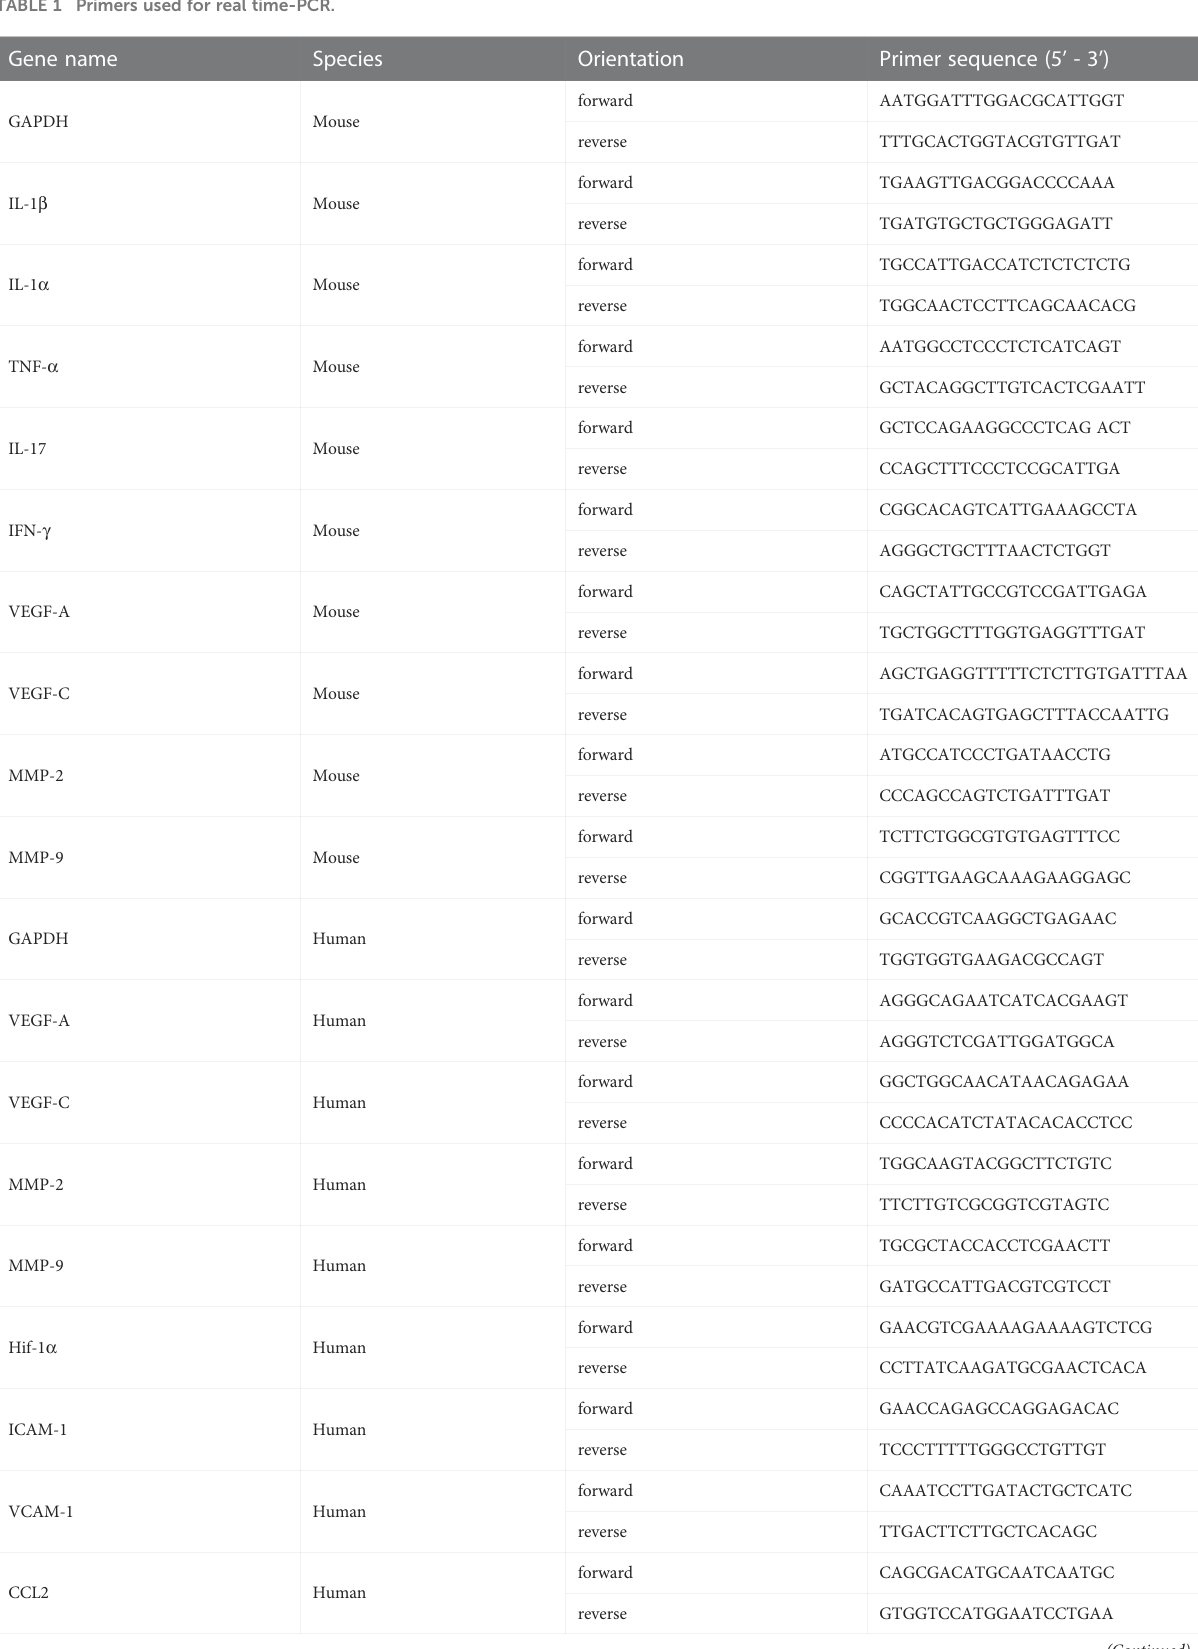
TABLE 1 Primers used for real